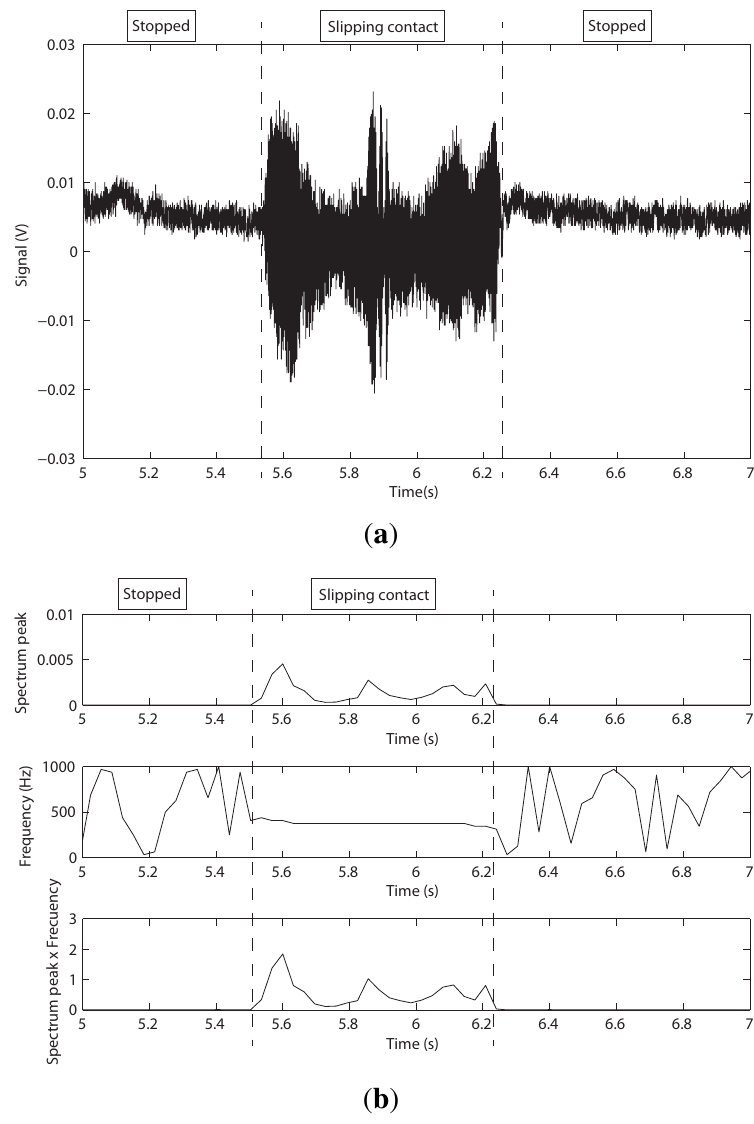
Figure 15. ( a ) Gauge signal finger 1 as a function of time; ( b ) spectrum peak and its frequency as a function of time (BarrettHand).